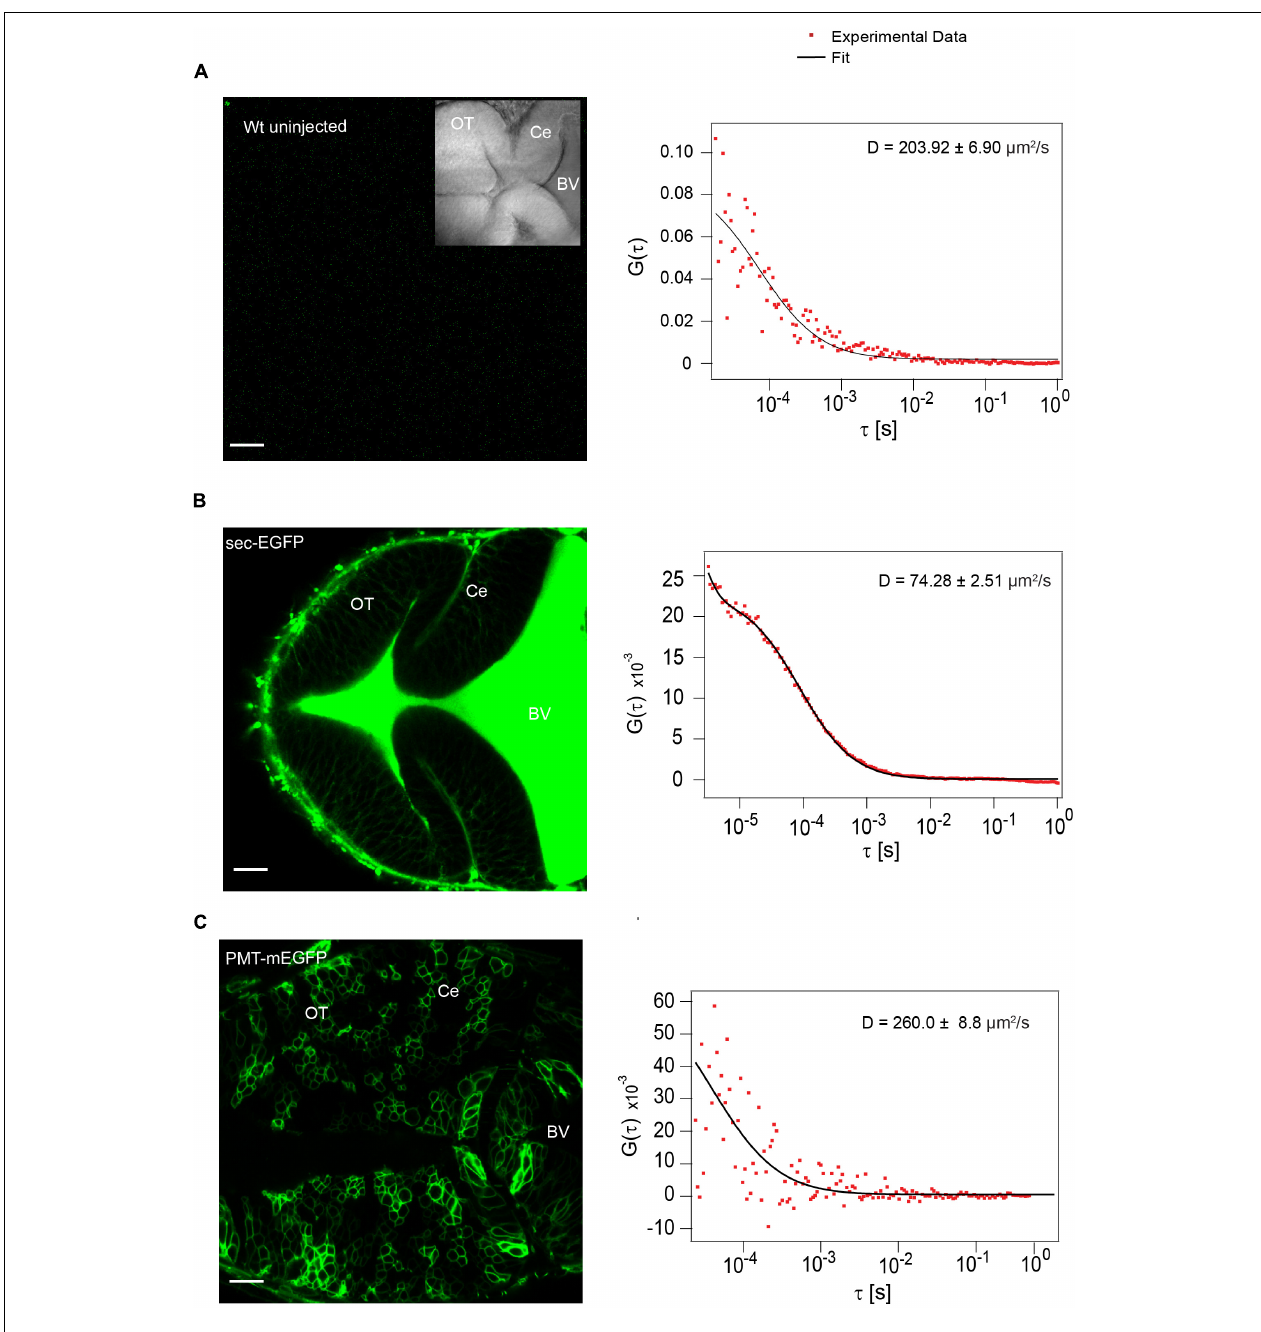
FIGURE 3 | Secretion of positive and negative control in the BV (A) Auto fluorescence signal from wild type (Wt) unlabeled zebrafish embryo and representative autocorrelation function (ACF; dots) and fit (line) of a FCS measurement in the BV at ∼ 48 hpf.). (B) Expression of sec-EGFP in the zebrafish brain at ∼ 48hpf (left) and a representative autocorrelation function (ACF; dots) and fit (line) of a FCS measurement in the BV (right). (C) Expression of PMT-mEGFP in the zebrafish brain at ∼ 48 hpf (left) and a representative autocorrelation function (ACF; dots) and fit (line) of a FCS measurement in the BV of zebrafish (right). The FCS curves were fitted using 3D-2particle-1triplet model. BV, fourth brain ventricle; Ce, cerebellum; OT, optic tectum. Orientation: anterior to the left. Scale bar 20 µ